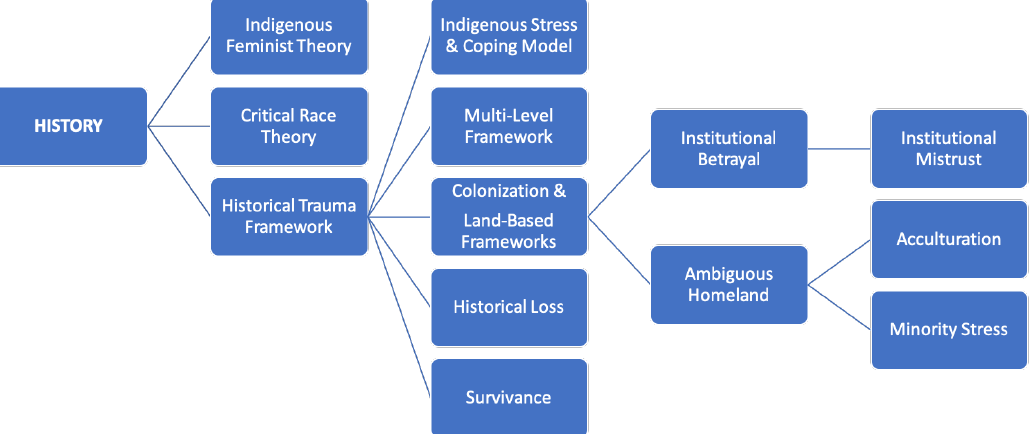
Figure 2. Map of Theoretical